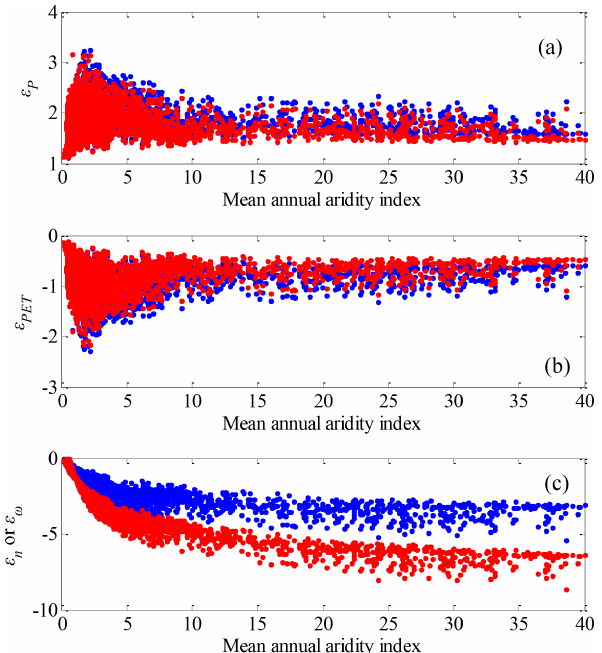
Figure 6. The relationship between mean annual aridity index and (a) P elasticity, (b) PET elasticity, and (c) parameter elasticity. The blue points represent the case of Eq. (2), and the red points represent the case of Eq.